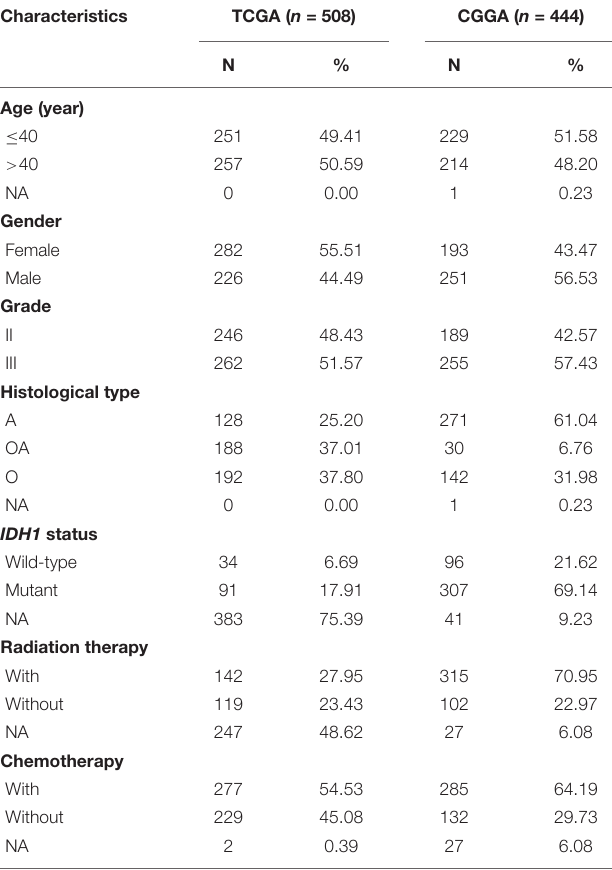
TABLE 1 | Detailed characteristics of included patients.